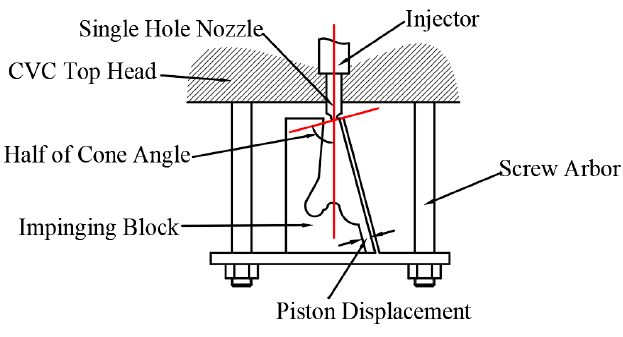
Figure 8. Schematic diagram of the installation of the impinging block and the injector in the CVC.